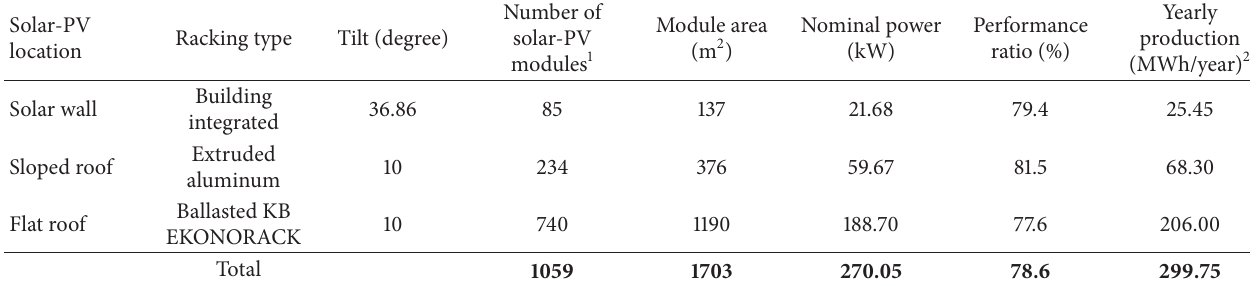
Table 2: Technical details of the three locations of solar-PV array.